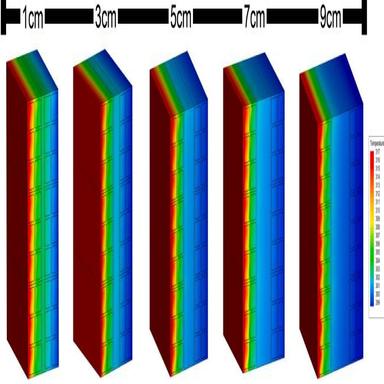
Temperature distribution for different thickness.